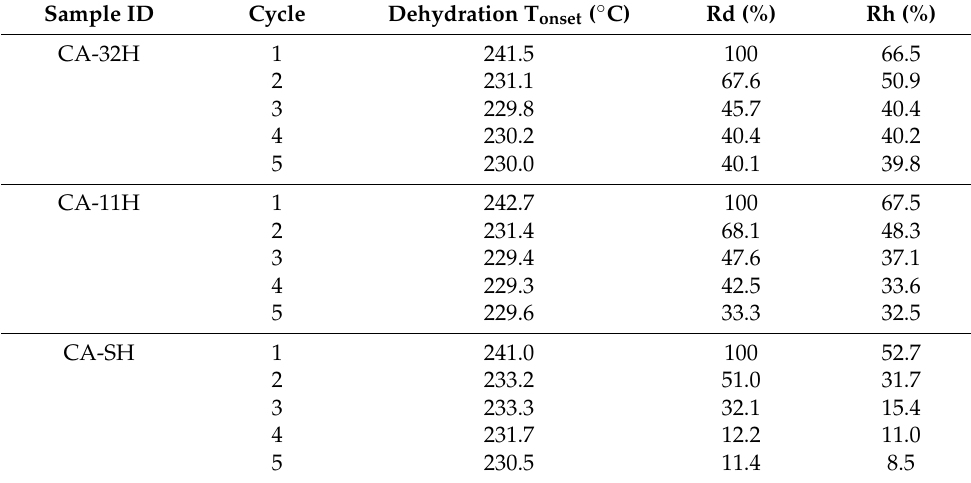
Table 5. Thermogravimetric performances per